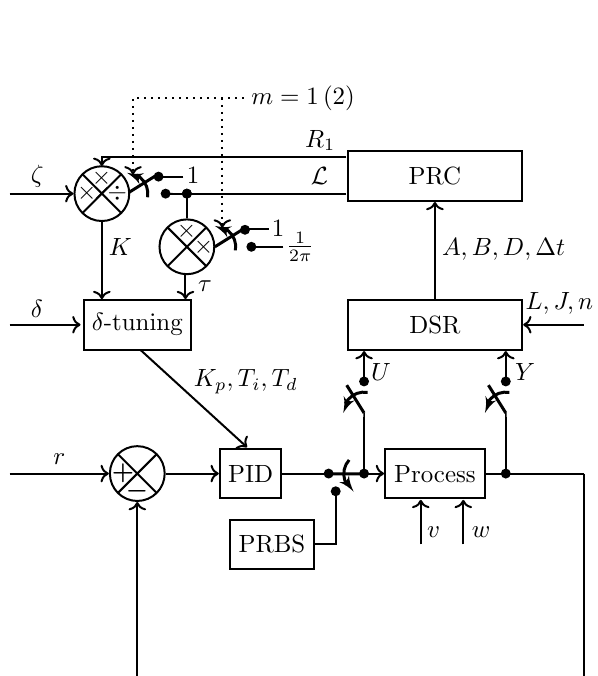
Figure 1: The figure is illustrating the proposed Algo- rtihm 1 with a standard feedback system. The data, U and Y , are logged as long as the PRBS switch is turned on. The figure shows the integrator plus time delay ( m = 1) or double integrator plus time delay model ( m = 2) (Eq. (1)) approximation method based on the unit reaction rate, R 1 , and lag, L , computed from a open loop unit step re- sponse or Process Reaction Rate (PRC) (see the works Dalen and Di Ruscio (2018a,b,c) for details).